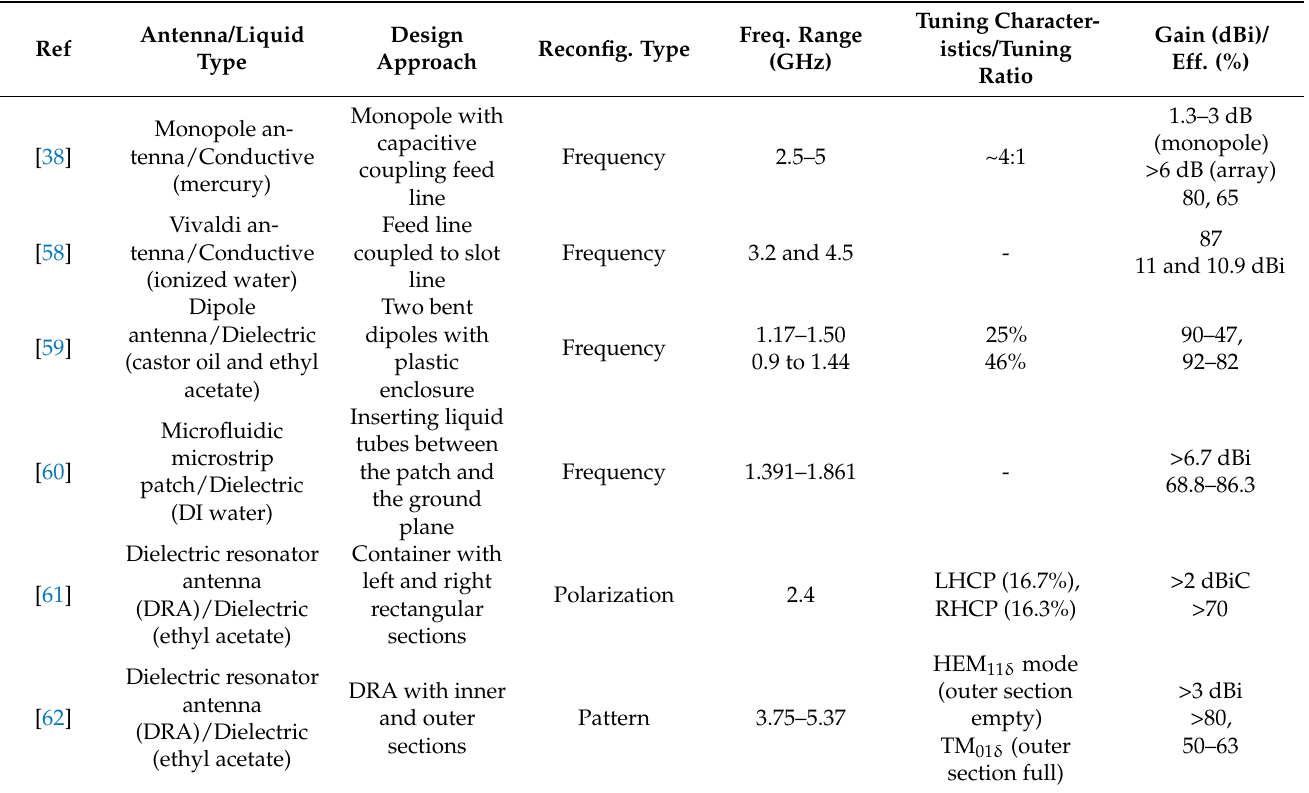
Table 5. Summary of reconfigurable antennas using other conductive and dielectric